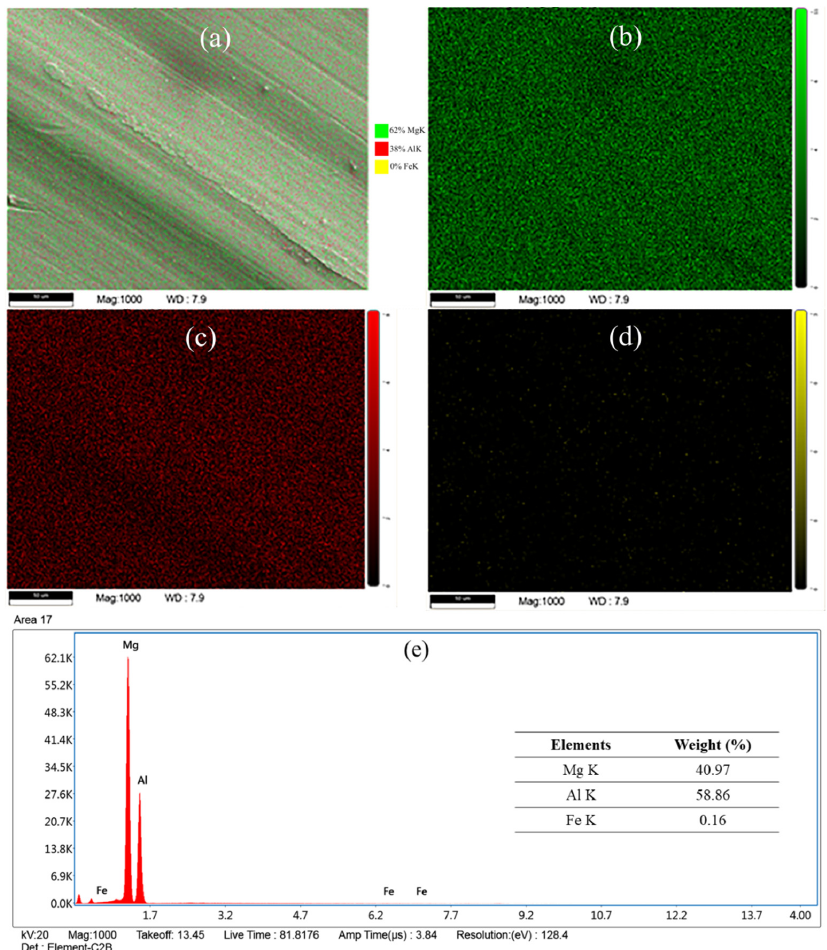
Figure 15. The scanning electron microscopy (EDS) mapping of ( a ) the workpiece material adhered to the tool during welding, showing the presence of ( b ) Mg, ( c ) Al, ( d ) Fe and ( e ) the intensity peak oftheconstituentmaterials.